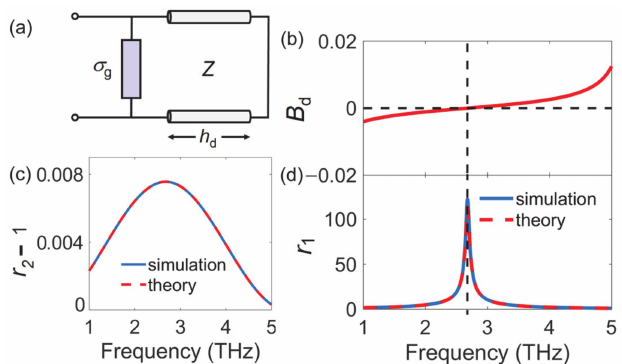
Figure 2. ( a ) The transmission line model of graphene with back mirror. ( b ) Susceptance B d of the short-circuited transmission line as a function of frequency. Reflection amplitude as a function of frequency when ( c ) σ g = − 10 − 5 + 0 i S and ( d ) σ g = − 0.0027 + i 0 S. The solid lines are the COMSOL simulation results, and the dashed lines are the theoretical